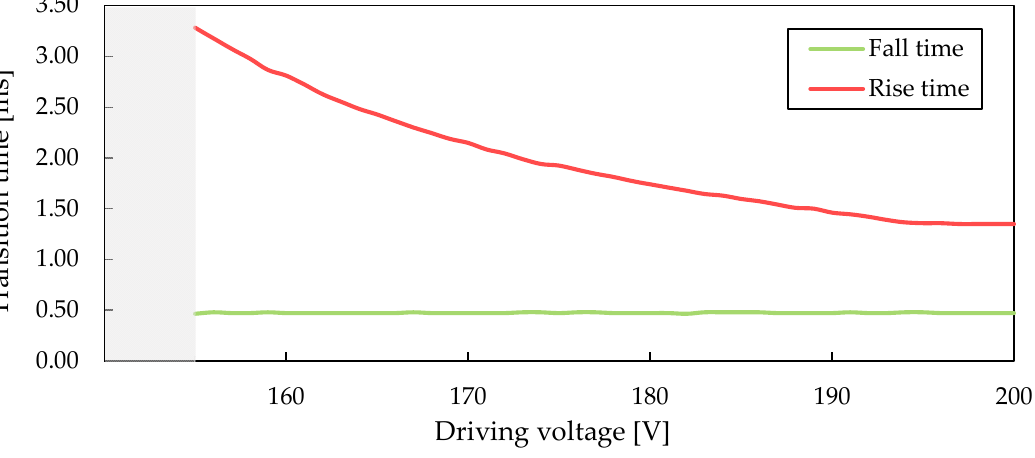
Figure 5. Dependence of rise and fall time of cholesteric LC (pitch: 412 nm) diffusers on the applied driving voltage, white LED as light source.